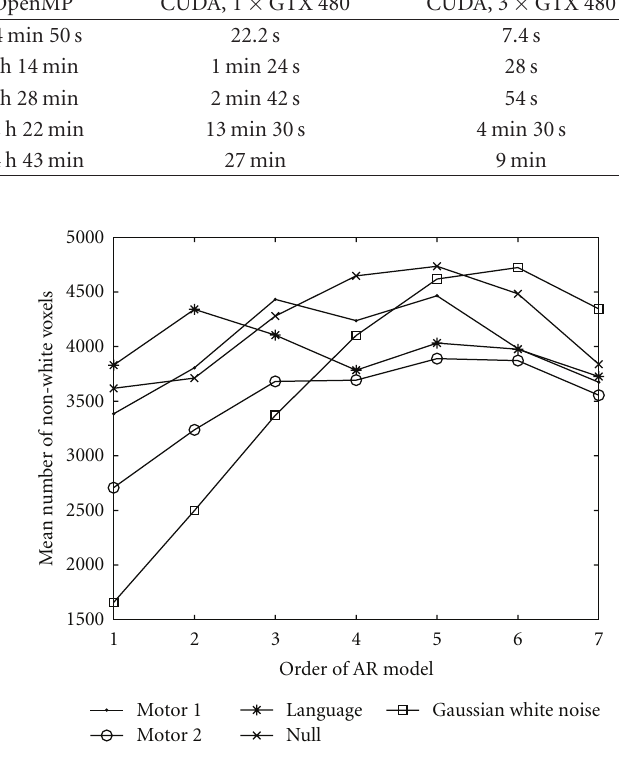
Figure 6: Mean number of voxels classified as nonwhite by the Ljung-Box test (1–10 time lags were tested and the mean number of nonwhite voxels for the 10 tests was saved). No spatial smoothing was applied to the estimated auto correlations prior to the Ljung- Box test. The number of nonwhite voxels for Gaussian white noise is included as reference (no whitening was applied to the